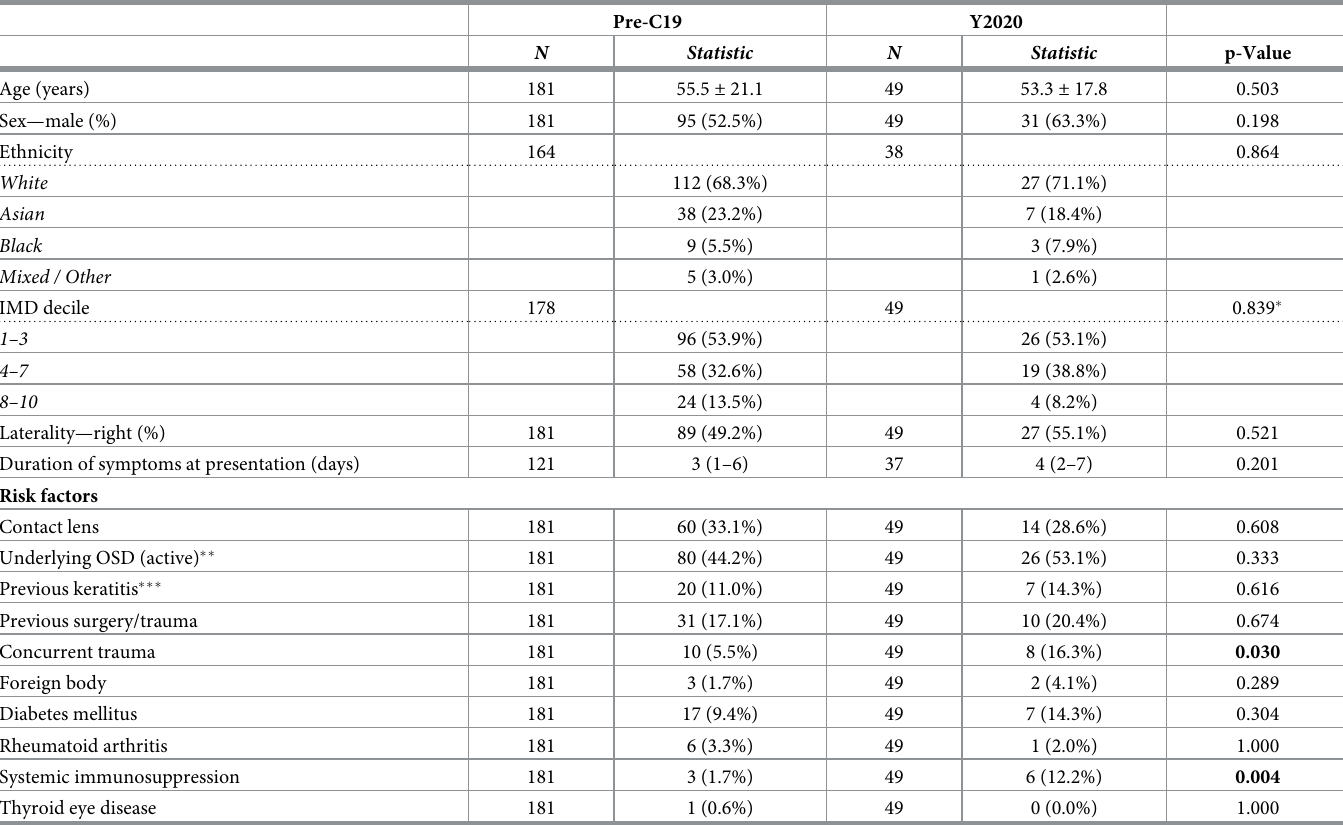
Table 1. Characteristics of patients presenting with microbial